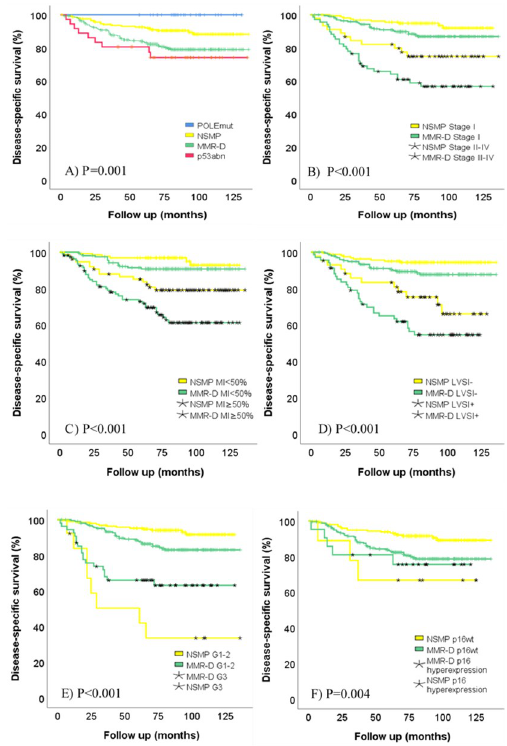
Fig 2. Kaplan-Meier curves for disease-specific survival according to TCGA-based molecular subgroups and single risk factors within NSMP/MMR-D subgroups: A) Molecular classification, B) FIGO 2009 stage, C) Myometrial invasion (MI), D) Lymphovascular space invasion (LVSI), E) Grade of differentiation, F) p16 expression. POLEmut = POLE mutated, NSMP = no specific molecular profile (yellow), MMR-D = mismatch repair deficient (green), p53abn = p53